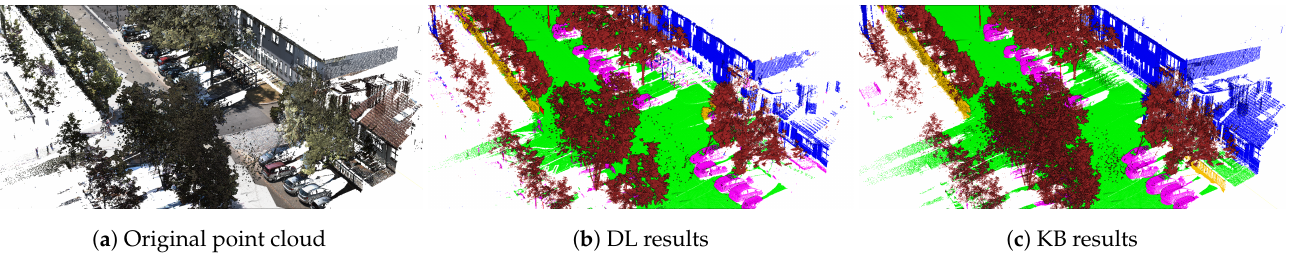
Figure 8. Example of bush and barriers semantic segmentation